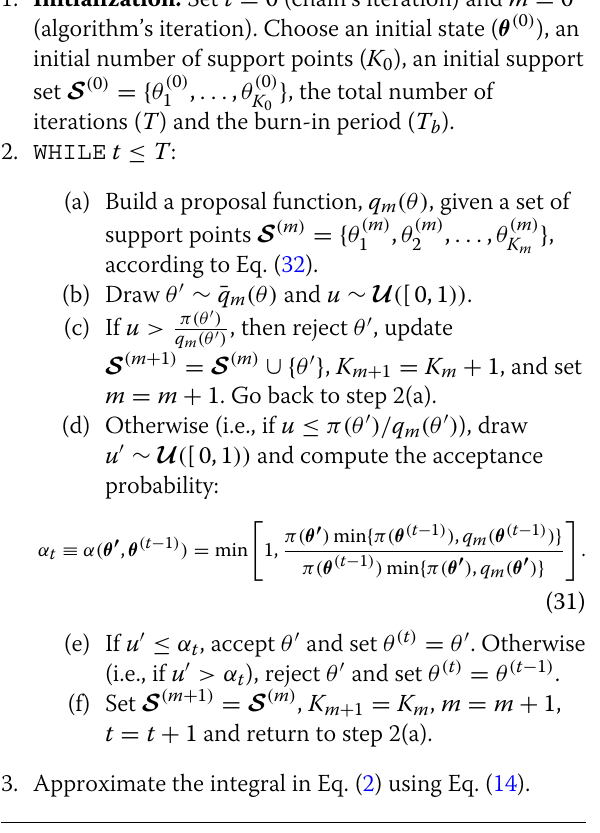
Algorithm 13 Adaptive Rejection Metropolis